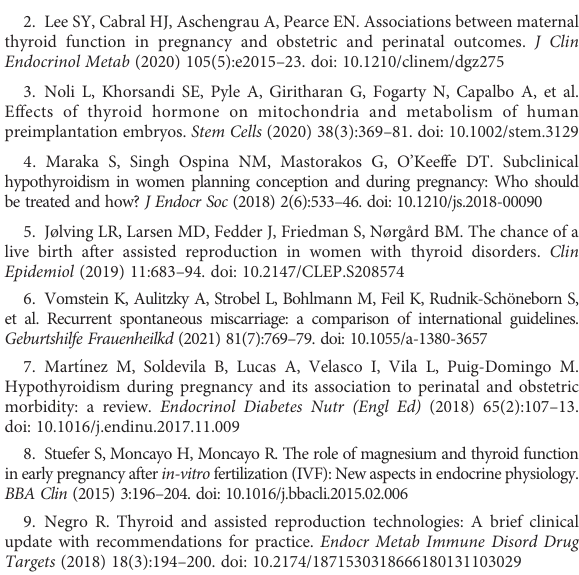
SUPPLEMENTARY FIGURE 1 (A) Funnel plot - proportions for low x high TSH by pregnancy, and (B) Baujat plot - proportions for low x high TSH by pregnancy. SUPPLEMENTARY FIGURE 2 Forest plot - Meta-analysis of means: mean TSH for pregnancy (subgroup low and high TSH). SUPPLEMENTARY FIGURE 3 (A) Funnel plot - proportions for low x high TSH by delivery rate, and (B) Baujat plot – proportions for low x high TSH by delivery